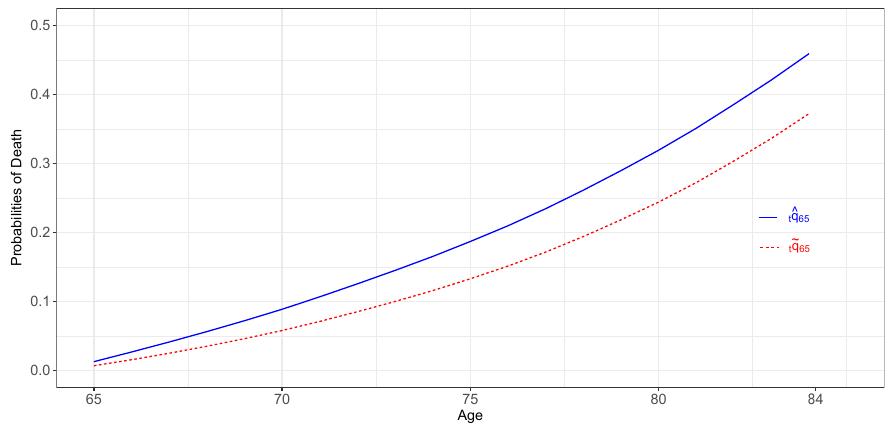
Figure 5. Death probabilities t (cid:98) q cred x and t (cid:101) q cred x under the SPM method for